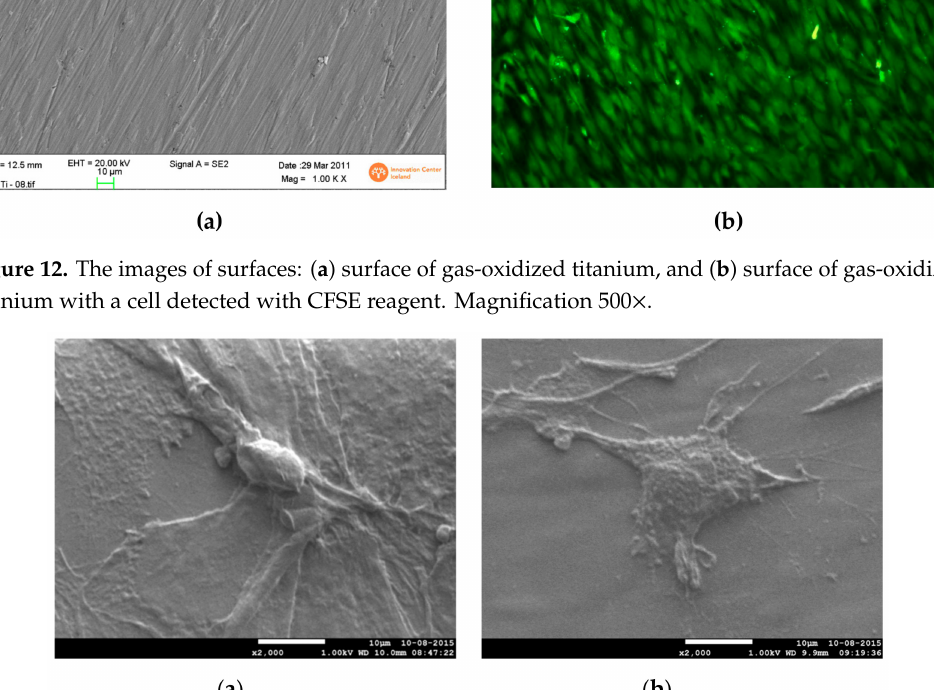
Figure 13. Osteoblasts on titanium surface coated with chitosan of shrimp origin: ( a ) DD 87%, and ( b ) DD 94%. Magnification 2000 × (scale bar 10 µ